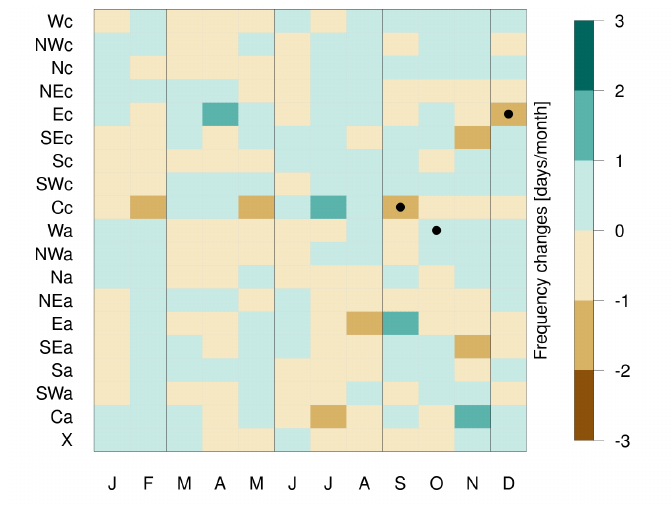
Figure 8. Mean monthly changes in the occurrence of weather types in the MPI-ESM-LR RCP8.5 projection (2071–2100) compared to the historical simulation (1971–2000). The dots mark statistically significant